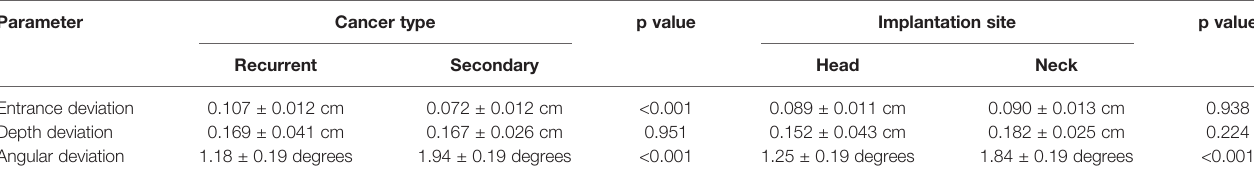
TABLE 3 | Subgroup analysis of pre-plan and intraoperative parameter deviation (univariate analysis).